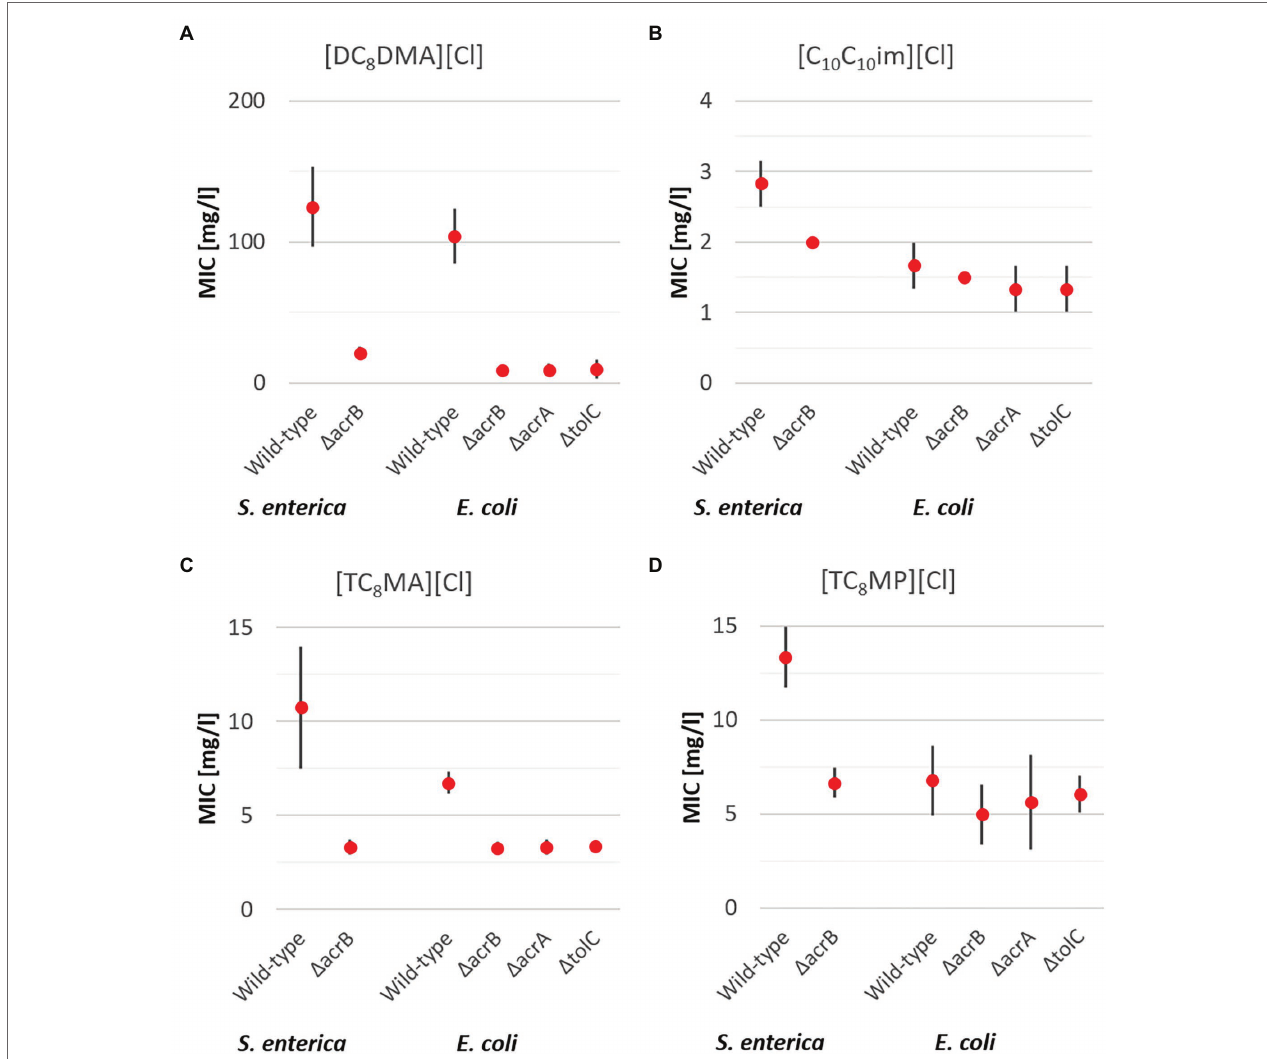
FIGURE 3 | Mean MIC values for antimicrobial ILs with two elongated alkyl side chains [DC 8 DMA][Cl] (A) and [C 10 C 10 im][Cl] (B) and three elongated alkyl side chains [TC 8 MA][Cl] (C) and [TC 8 MP][Cl] (D) including upper and lower limits of 95% CIs for the respective S. enterica and E. coli strains after 24 h incubation at 37 °